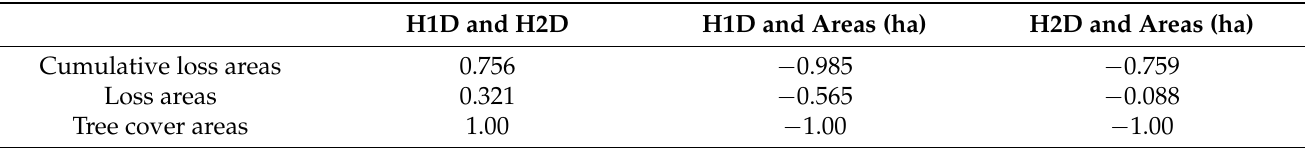
Table 5. Spearman’s rank correlation coefficients between Higuchi dimensions 1D and 2D and between Higuchi dimensions and corresponding